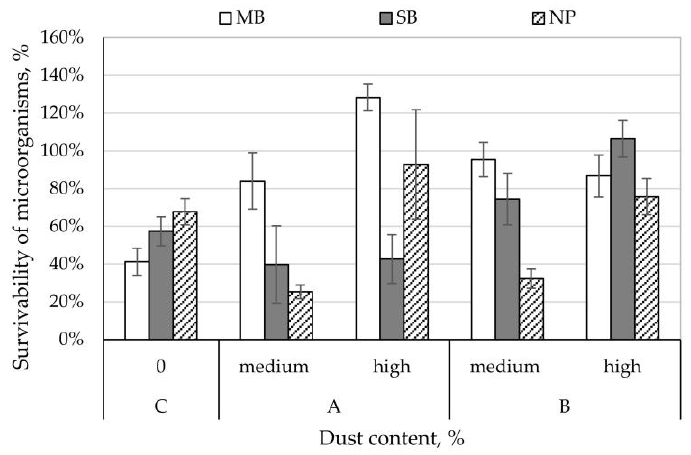
Figure 4. Survivability of Aspergillus niger moulds on filtering nonwovens depending on dust-type and content.